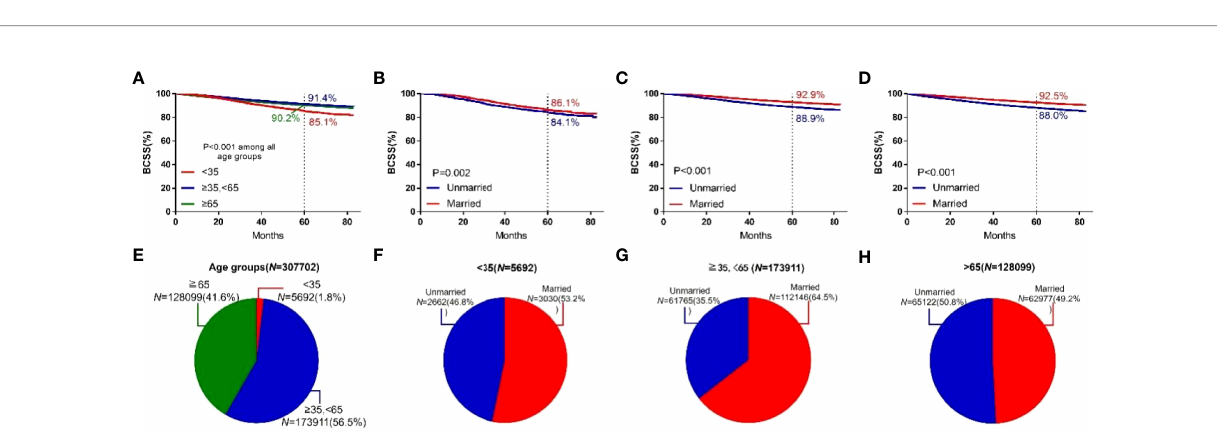
FIGURE 4 | BCSS curves according to the age groups. (A) and subject proportions of the age groups (E) . Survival curves of each marital status for <35 years old (B) , ≥ 35, <65years old (C) and ≧ 65years old (D) and subject proportions of each marital status for <35 years old (F) , ≥ 35, <65years old (G) and ≧ 65years old (H) were depicted.